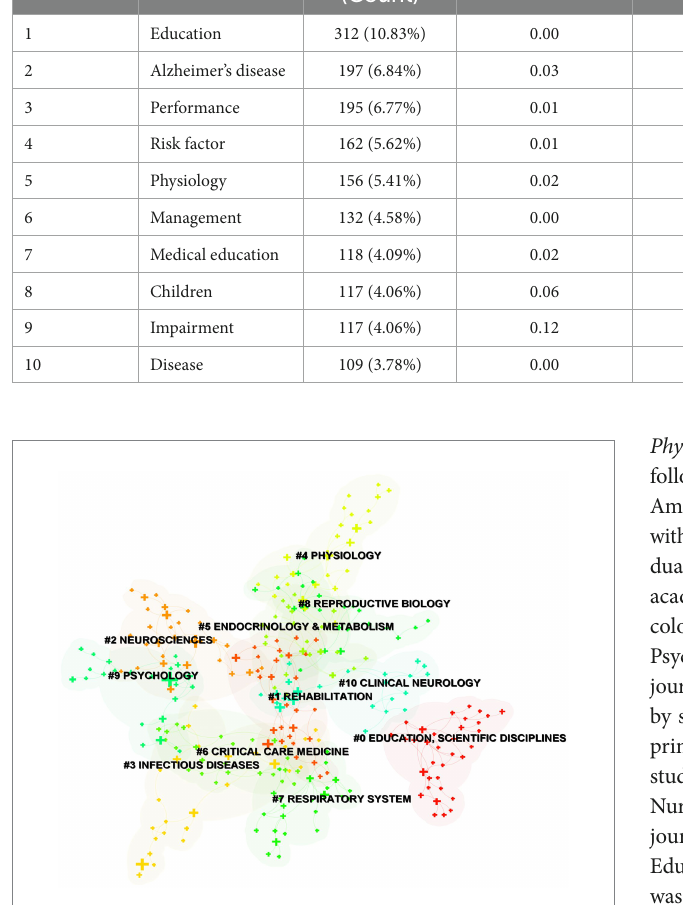
FIGURE 5 The network of keywords clusters in subject